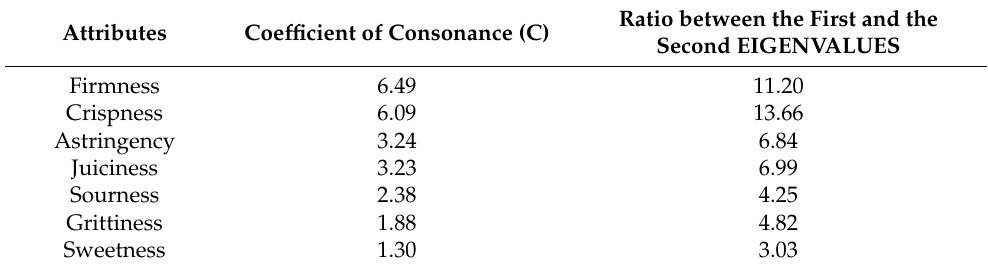
Table 9. Panel consonance. Results from independent PCA of the data for each attribute obtained from the Conventional Descriptive